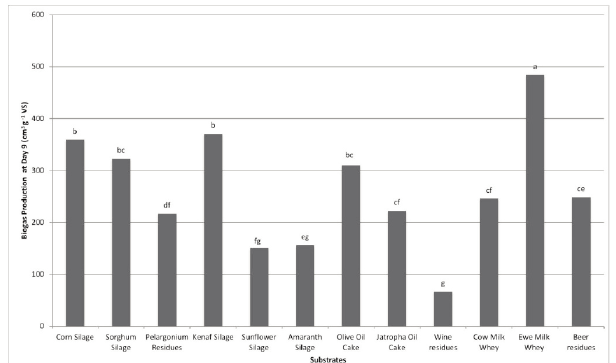
Fig. 2 - BioGas cumulate production (cm 3 g -1 VS) the end of day (t9) 9 for different substrates. Different letters means signifi- cative differences between substrates according to Bonferroni Multiple Comparisons Test (P<0.05).